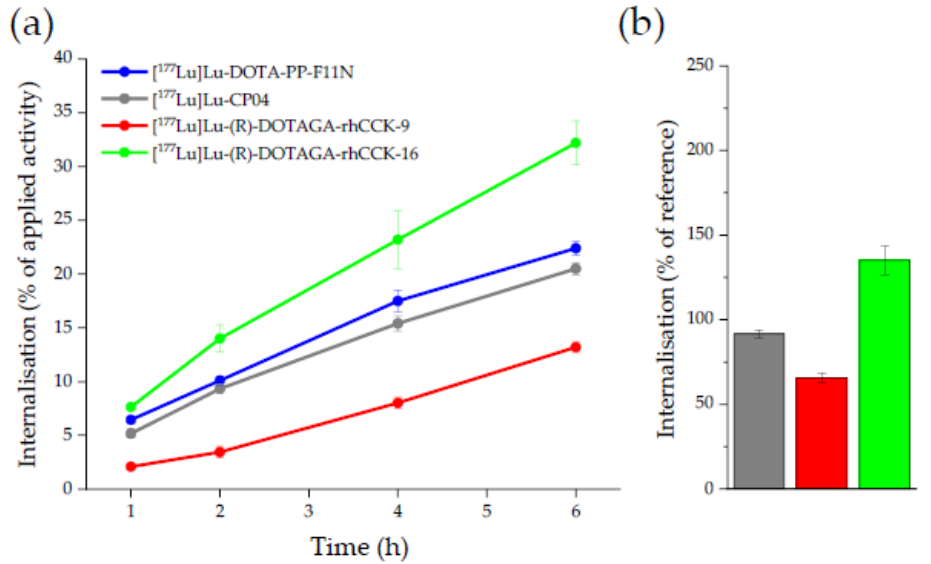
Figure 3. ( a ) CCK-2R-mediated internalisation (0.25 pmol/well) on AR42J cells as percent (%) of the applied activity (incubation at 37 °C for 1, 2, 4 and 6 h, RPMI 1640, 5 m M L-Gln, 5 mL non-essential amino acids (100×), 10% FCS + 5% BSA ( v / v ), 3.0 × 10 5 cells/mL/well). ( b ) CCK-2R mediated internalisation (% of the reference [ 177 Lu]Lu-DOTA-PP-F11N) of [ 177 Lu]Lu-CP04 (grey), [ 177 Lu]Lu- ( R )-DOTAGA-rhCCK-9 (red) and [ 177 Lu]Lu-( R )-DOTAGA-rhCCK-16 (green) after incubation